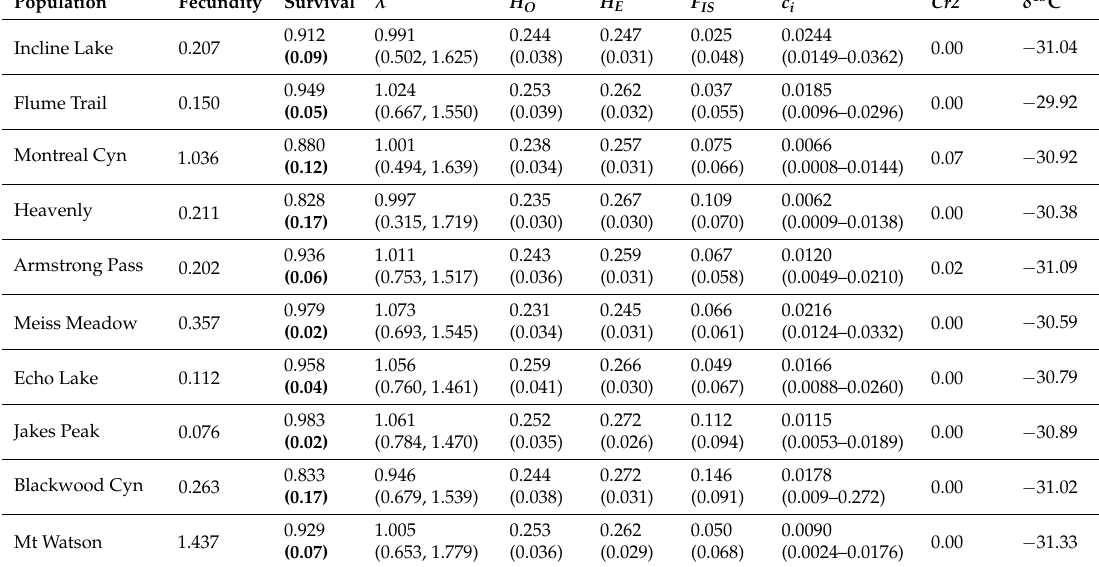
Table 2. Demographic and genetic summaries for P. monticola populations from the Lake Tahoe Basin. Mean fecundity, survival (cumulative mortality in bold and parentheses below), and population growth rate ( λ along with 2.5% and 97.5% confidence intervals) from transition matrices. Genetic and diversity patterns from 160 marker loci with mean and variance (in parentheses) for H O , H E , F IS , c i , with 95% credible intervals for c i (in parentheses), Cr2 allele frequency, and mean water-use efficiency, δ 13 C.